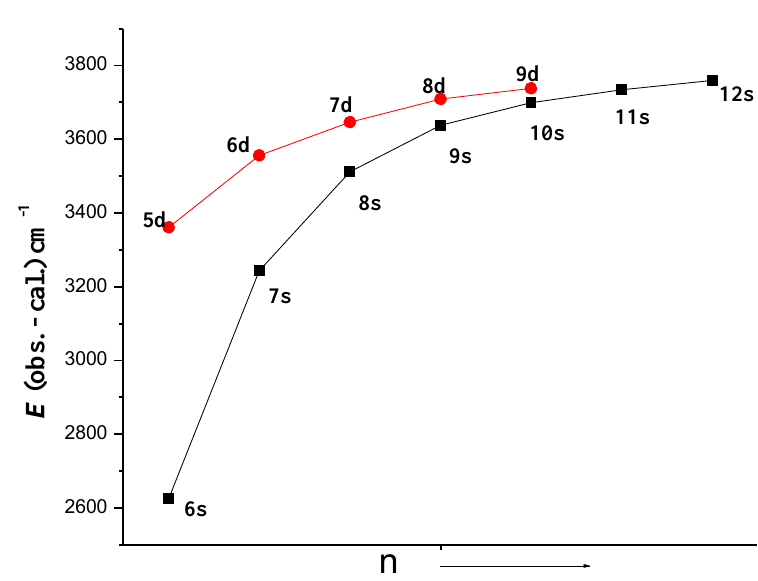
Figure 3. A plot E (obs-cal) for the 4d 10 n s and 4d 10 n d series in In III.